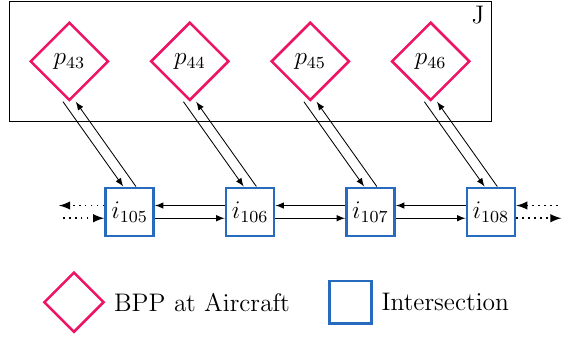
Figure 4. Detailed representation of request area